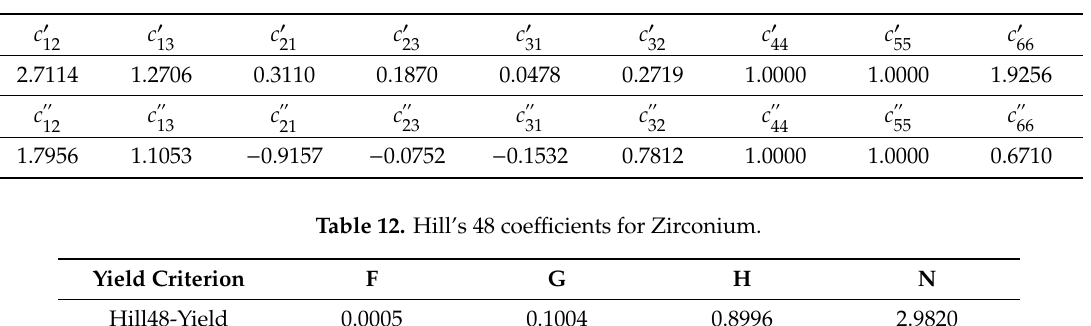
Table 11. Yld2004-18p coe ffi cients for Zirconium.